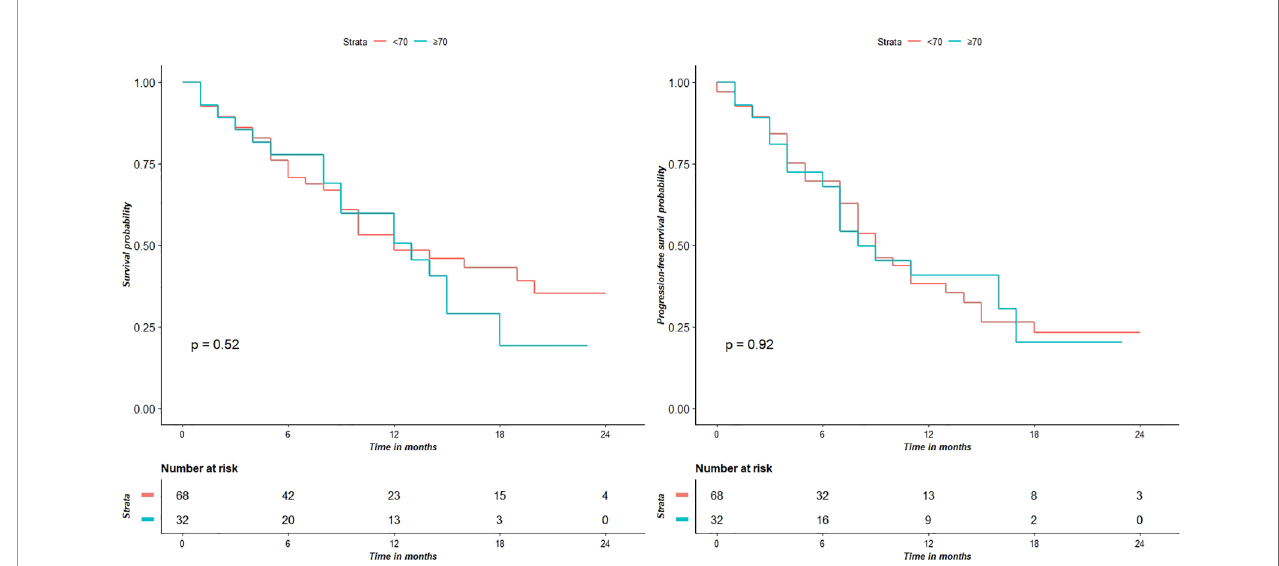
FIGURE 4 | Survival analyses show that the two groups do not have signi fi cantly different OS (p = 0.52) and PFS (p = 0.92)